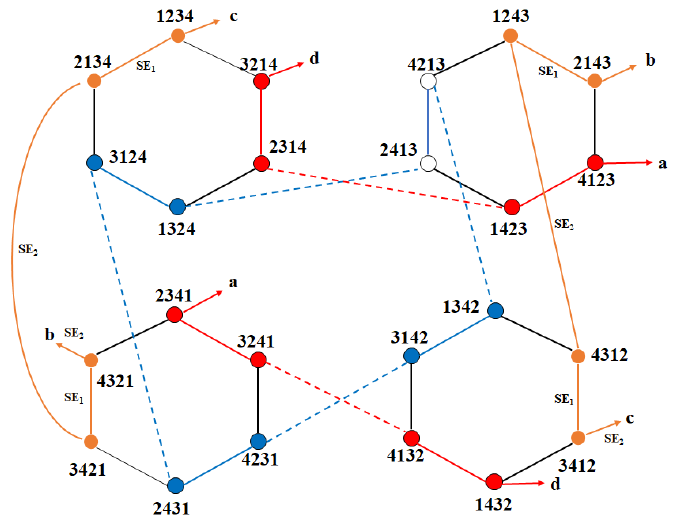
Figure 3. Subgraphs with a Hamiltonian cycle in LS 4 .